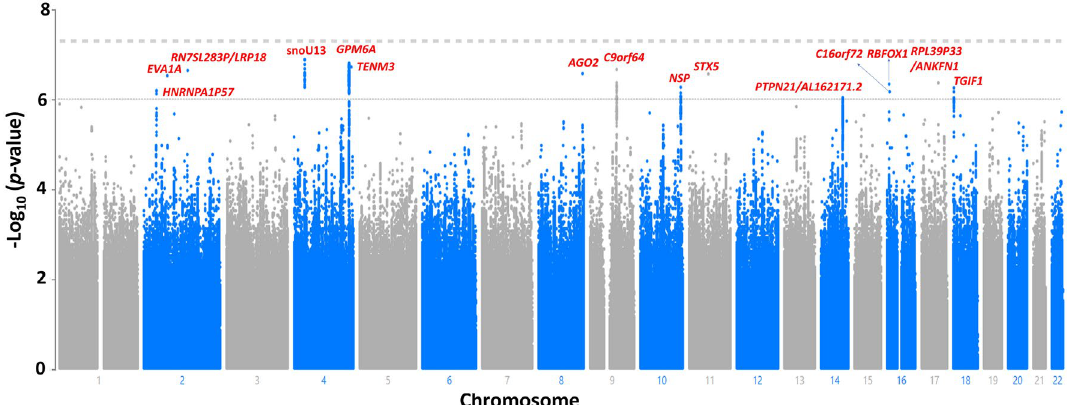
Figure 3. Manhattan plot for the genome-wide association study on tinnitus-related distress. The dashed gray line presents the genome-wide significance threshold ( p < 5E−8), and the dashed black line indicates the suggestive significance threshold ( p < E−6).